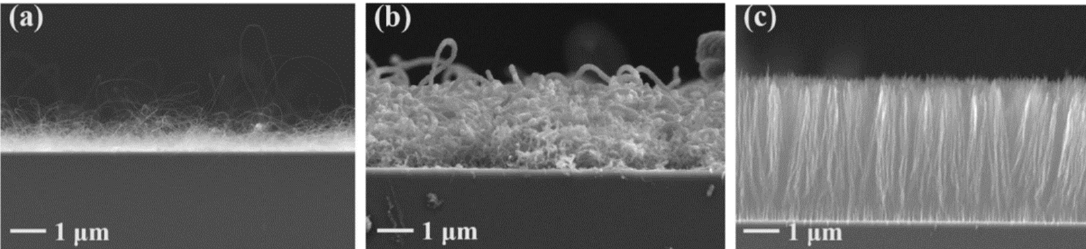
Figure 16. Cross-sectional SEM micrographs of CNT growth on the ZnO film at 800 °C, where: ( a ) presents the use of pure-thermal CVD in the presence of H 2 ; ( b ) or ( c ) PECVD with H 2 or NH 3 , respectively. Reprinted with permission from Yuan, Chemical Physics Letters; Ref. [94] copyright 2021, Elsevier.